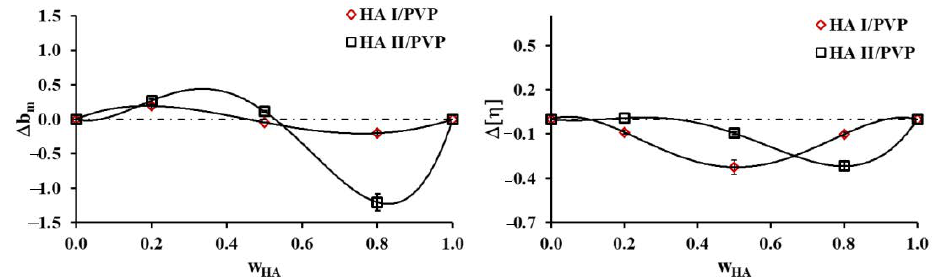
Figure 1. Values of miscibility parameters ( ∆ b m and ∆ [ η ] ) vs. HA weight fractions (w HA ) in HA I/PVP and HA II/PVP